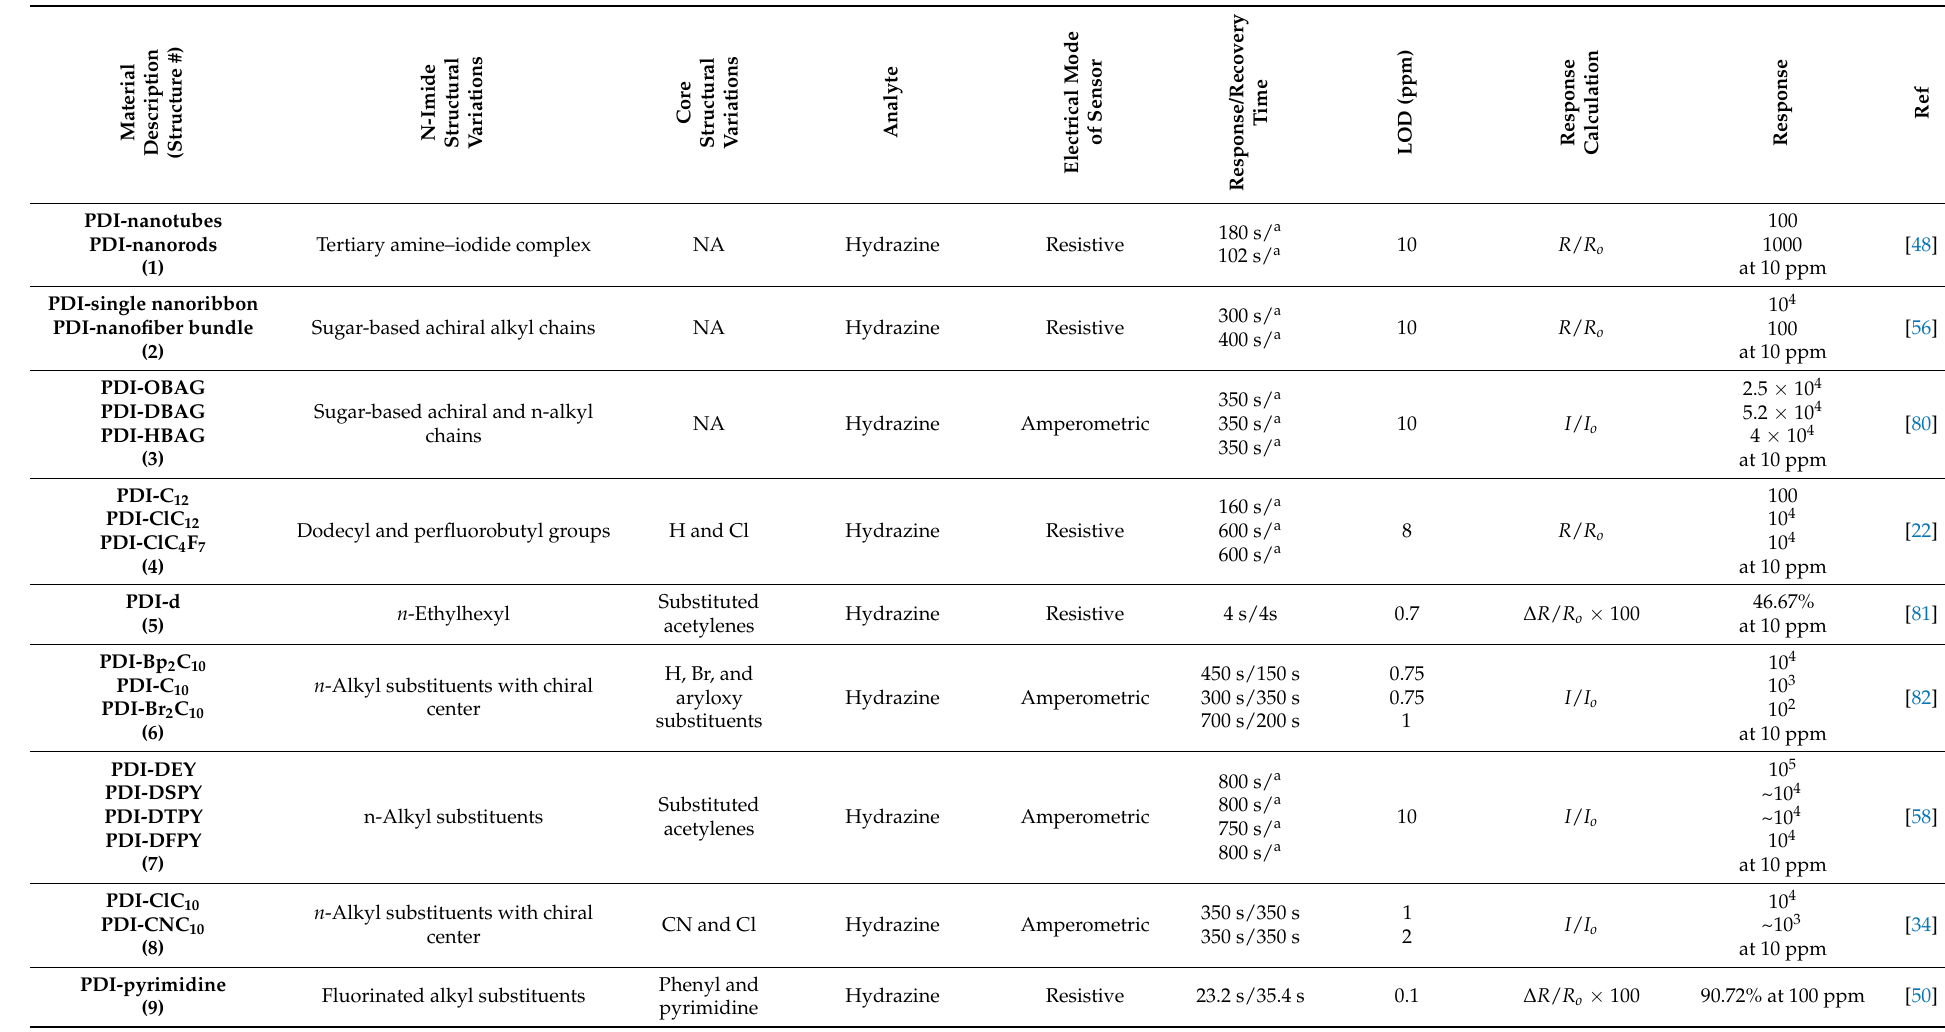
Table 1. Comparison of sensing performance of different derivatives of PDIs at room temperature (RT). Compare the descriptors used in this table to Figure 10 for structural clarification.